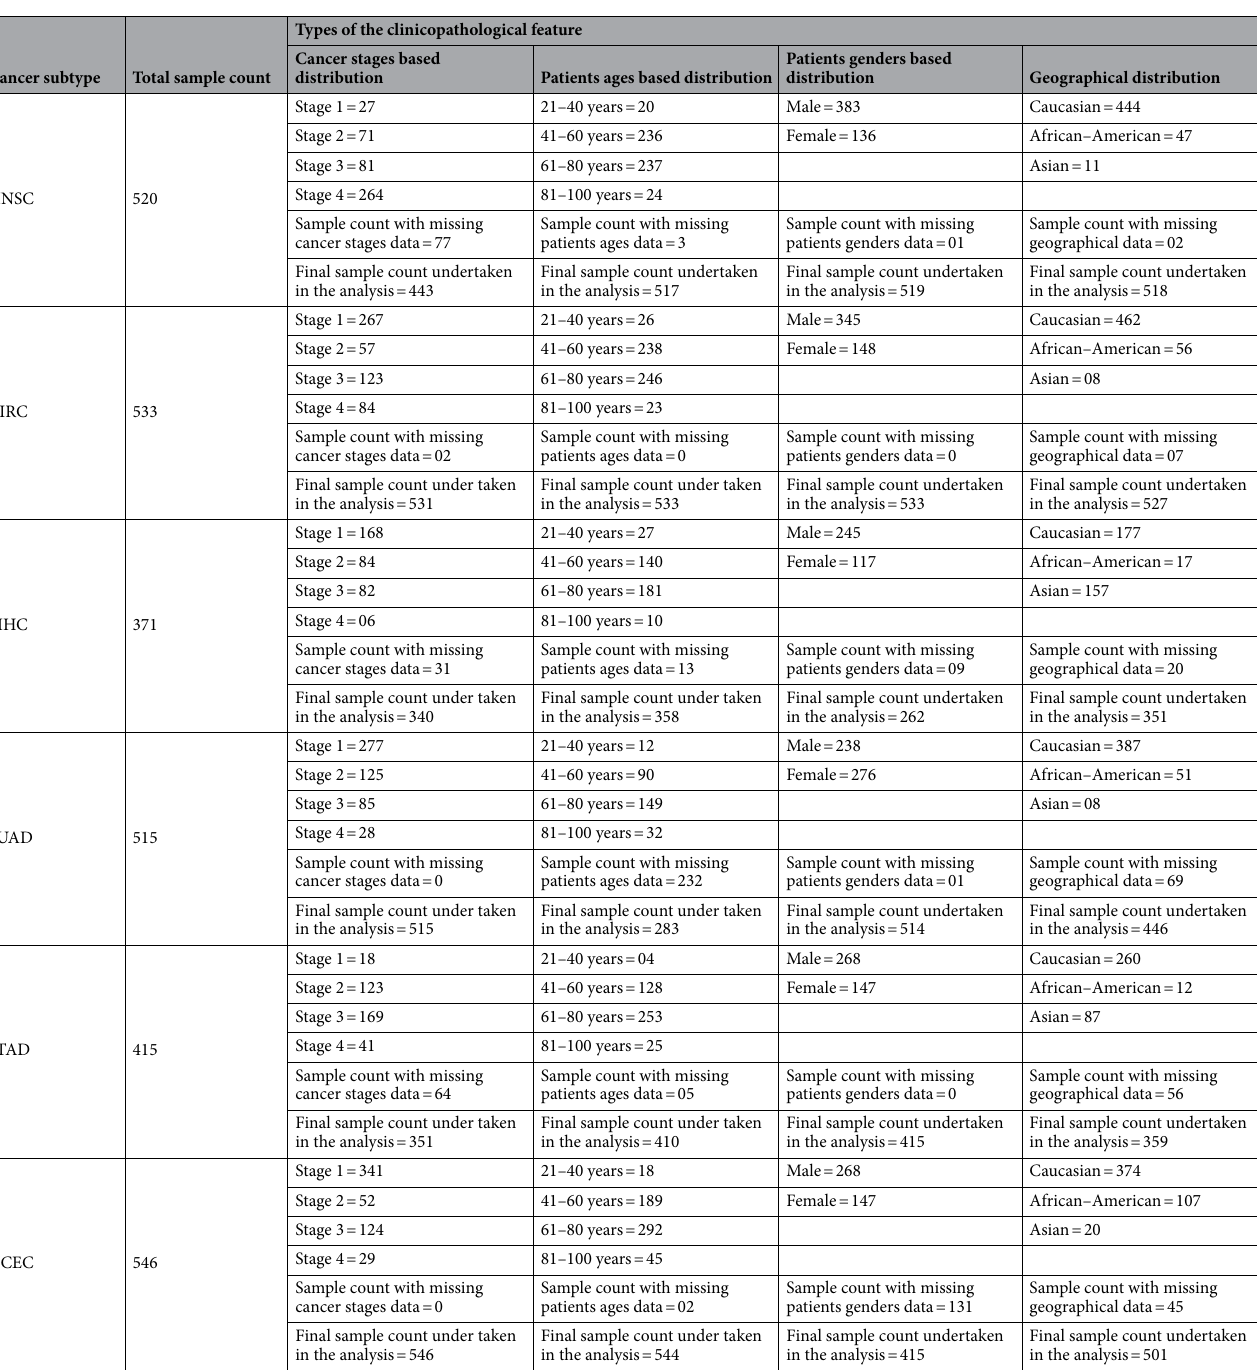
Table 1. Clinicopathological features based distribution of the HNSC, KIRC, LIHC, LUAD, STAD, and UCEC cohorts included in the present